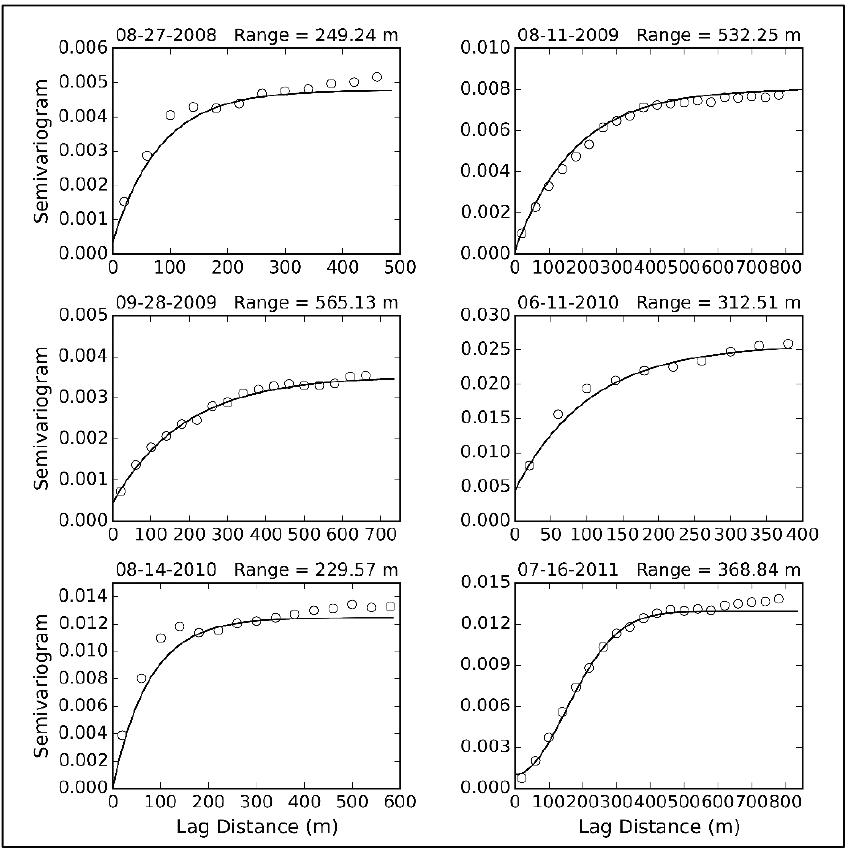
Figure 6. Optimization decreased the objective function from 0.84 to 0.28. The final values of and are 0.24 and 0.31, with weight coefficients of 0.44 and 0.56, respectively. Figure 5. Experimental variogram (circles) and fitted curve (black line) of the Temperature-Vegetation Dryness Index